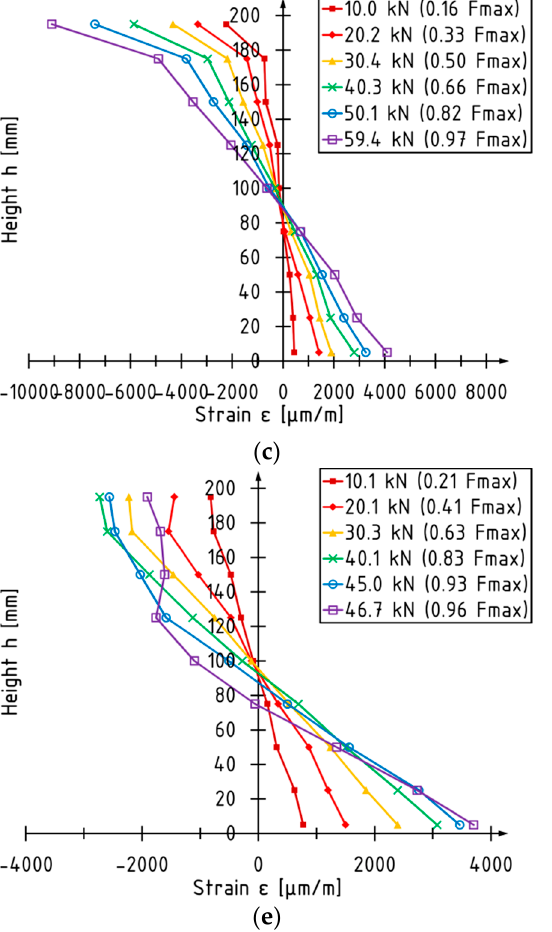
Figure 13. Strain profiles of selected tested beams: ( a ) A5; ( b ) B1; ( c ) C4; ( d ) D4; ( e ) E2; ( f ) F5.